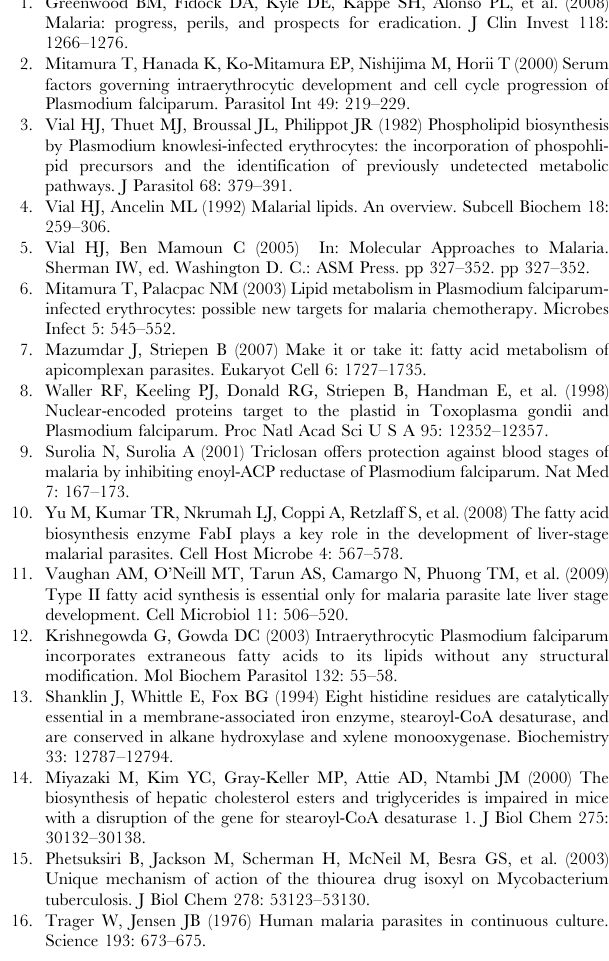
Figure S3 Increased resistance to isoxyl of a Mycobacterium bovis BCG strain overexpressing the central domain of